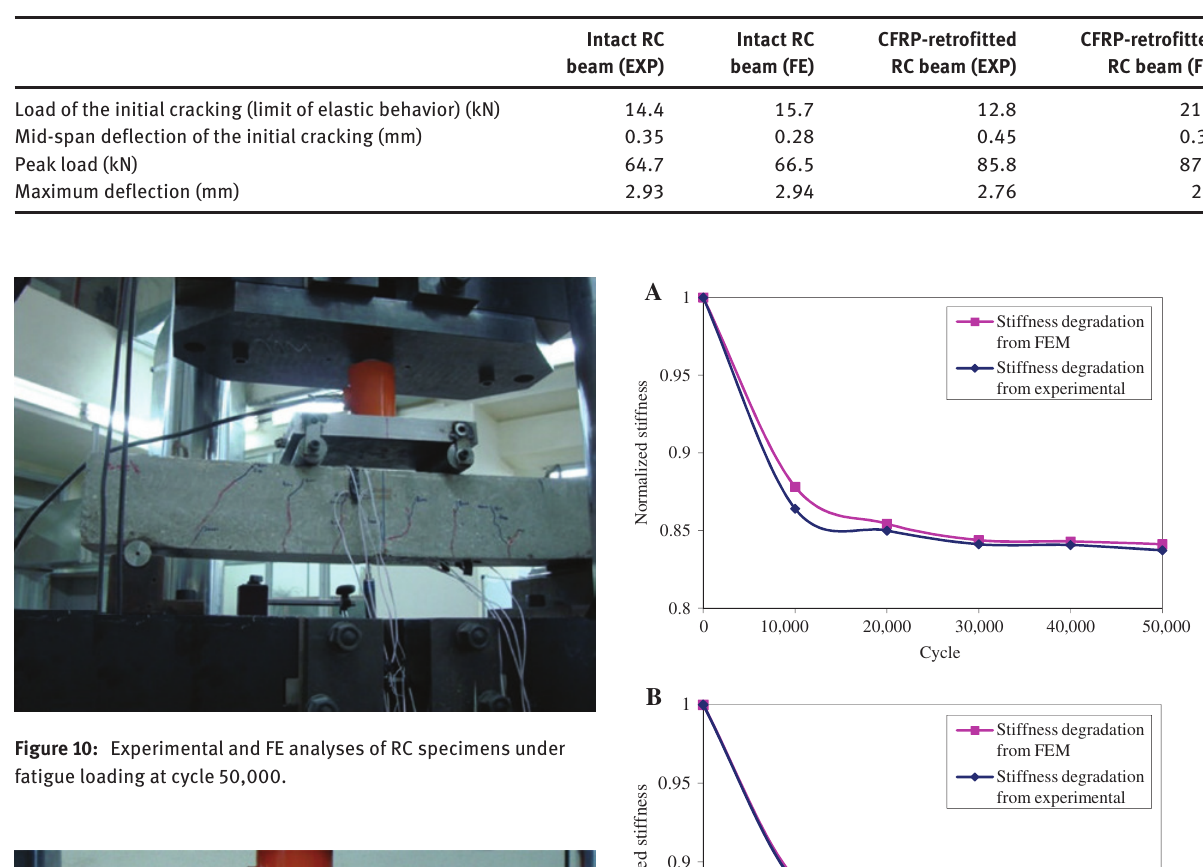
Table 3: Summary of results for pre-fatigue monotonic loading.